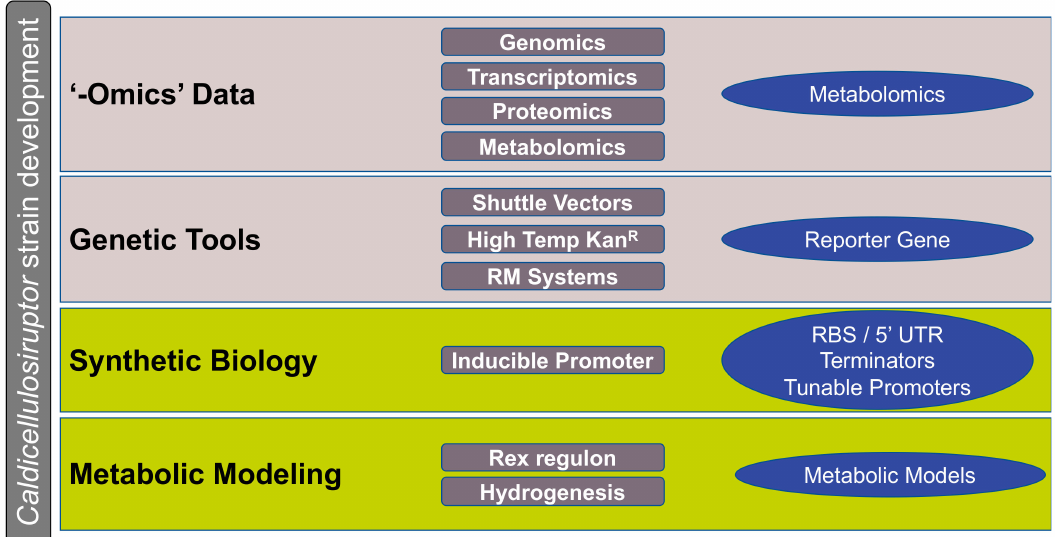
Figure2. Progressonthegenerationofdataandtoolsrequiredfor Caldicellulosiruptor straindevelopment. Maturing research areas are shaded in light gray, nascent research areas are shaded in light green. Tools and data discussed in this review are listed in dark gray rectangles, tools that require further development for strain development are highlighted in the blue ovals. Image modified from strategies illustrated by Yan and Fong